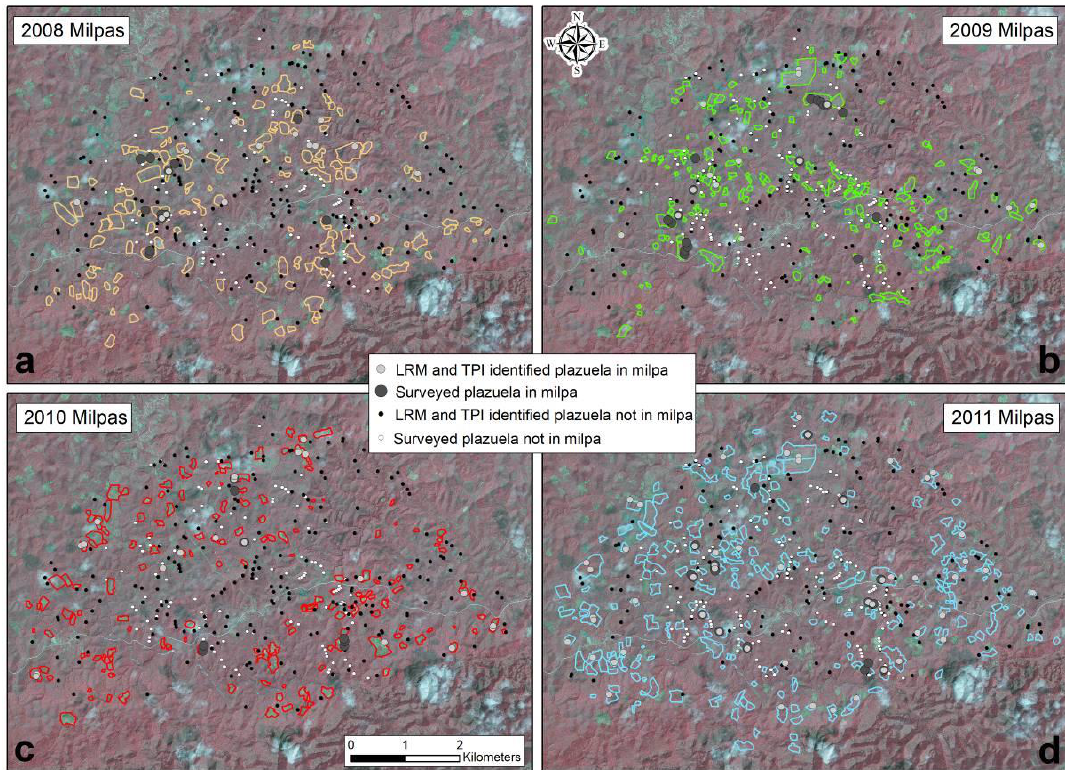
Figure 10. The location of milpas from ( a ) 2008, ( b ) 2009, ( c ) 2010, and ( d ) 2011, on a GeoEye-1 FCIR satellite image. Surveyed plazuelas within the annual milpa (large dark gray dot), and SLRM and TPI identified plazuelas (medium light gray dot) are indicated on the maps. More plazuelas are visible in 2011 milpas than in milpas from previous years. The location of surveyed (small white dot) and SLRM and TPI identified (small black dot) plazuelas are also noted.